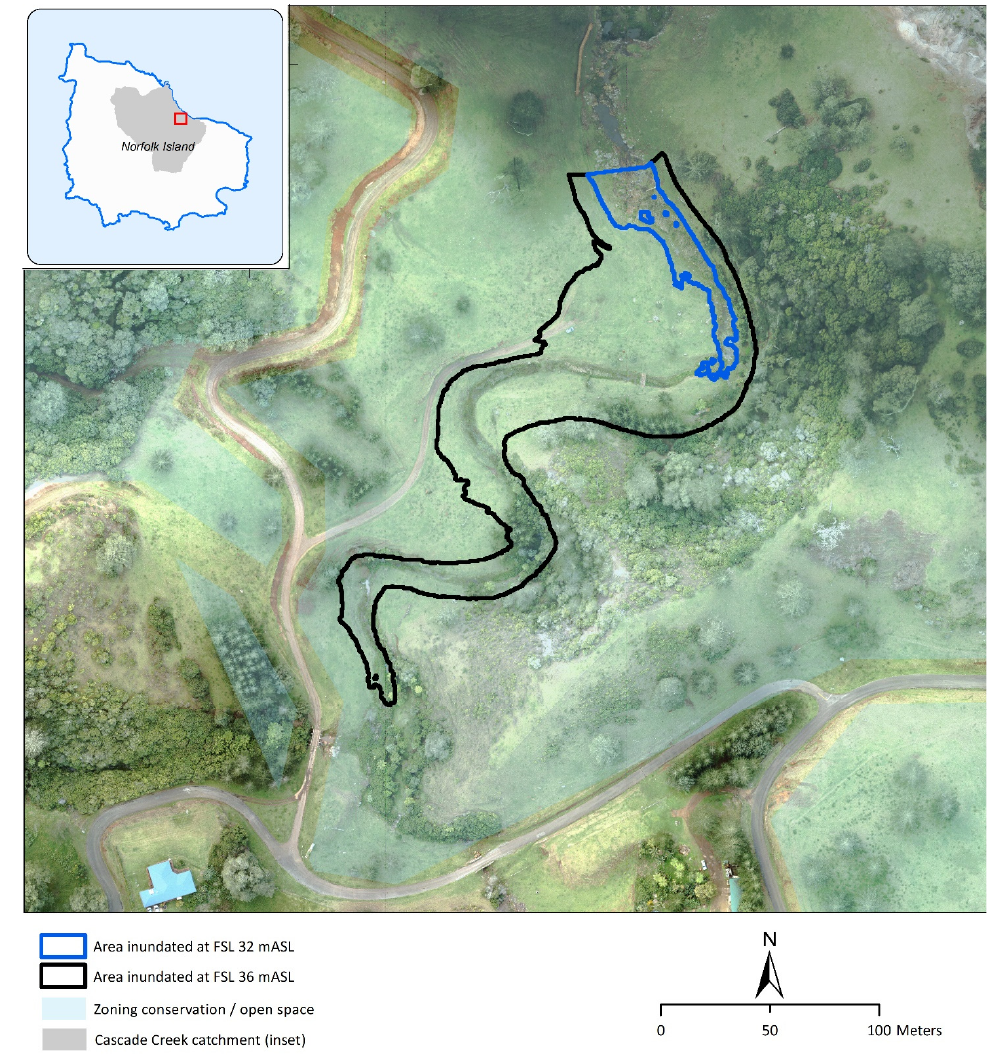
Figure 2. Potential Cockpit Falls dam and reservoir at full supply level 32 m ASL and 36 m ASL.